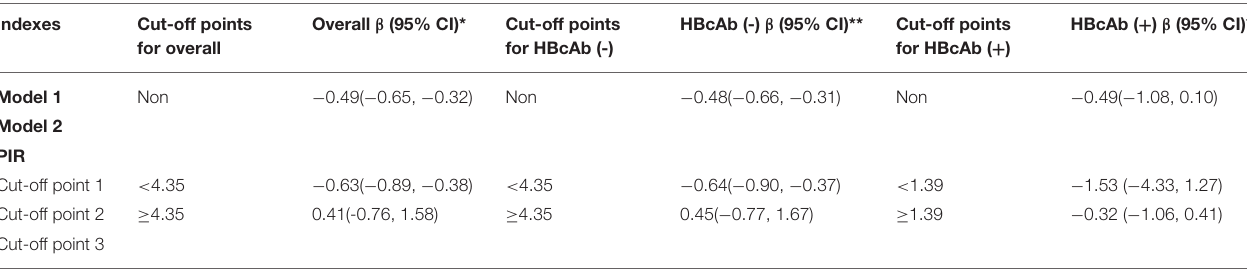
TABLE 5 | Cut-off points and segmentation effects for ratio of family